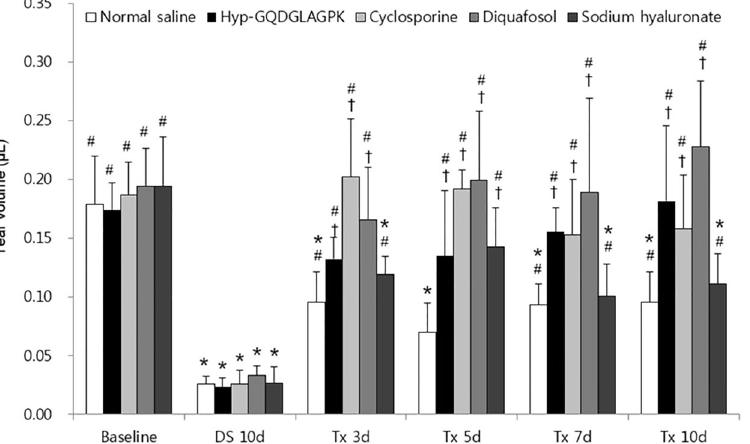
Figure 1. Effect of Hyp-GQDGLAGPK on tear production in the experimental dry eye mouse model. The tear volumes of the Hyp-GQDGLAGPK, cyclosporine, diquafosol, and sodium hyaluronate groups were measured at baseline, after 10 days of desiccation stress (DS 10d), and after treatment for 3, 5, 7, and 10 days. The quantitative data are presented as the means ± SD. The results are statistically significant by analysis of variance with the Tukey test at * p < 0.05 compared with baseline, # p < 0.05 compared with DS 10d and † p < 0.05 vs. corresponding value in the normal saline group. Baseline = before desiccation stress; DS 10d = immediately after desiccation stress for 10 days; Tx 3d, Tx 5d, Tx 7d and Tx 10d = 3, 5, 7 and 10 days after treatment with Hyp-GQDGLAGPK, cyclosporine, diquafosol, and sodium hyaluronate eye drops,